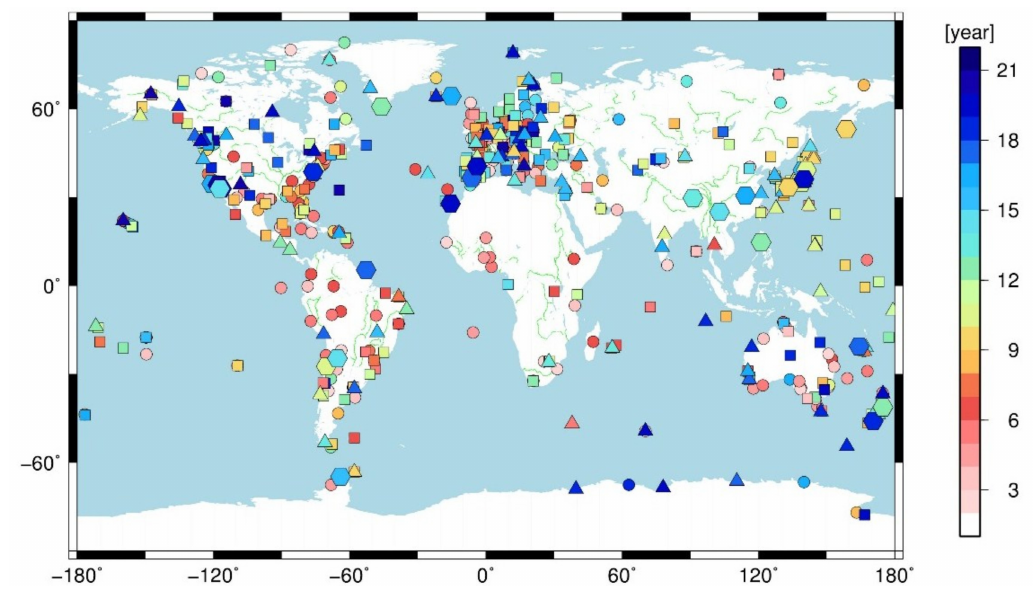
Figure 1. The global distributed stations with different observation time span and numbers of offset. Circle: no offsets found in the time series; square: 1–2 offsets; triangle: 3–4 offsets; hexagon: more than 4 offsets in the time